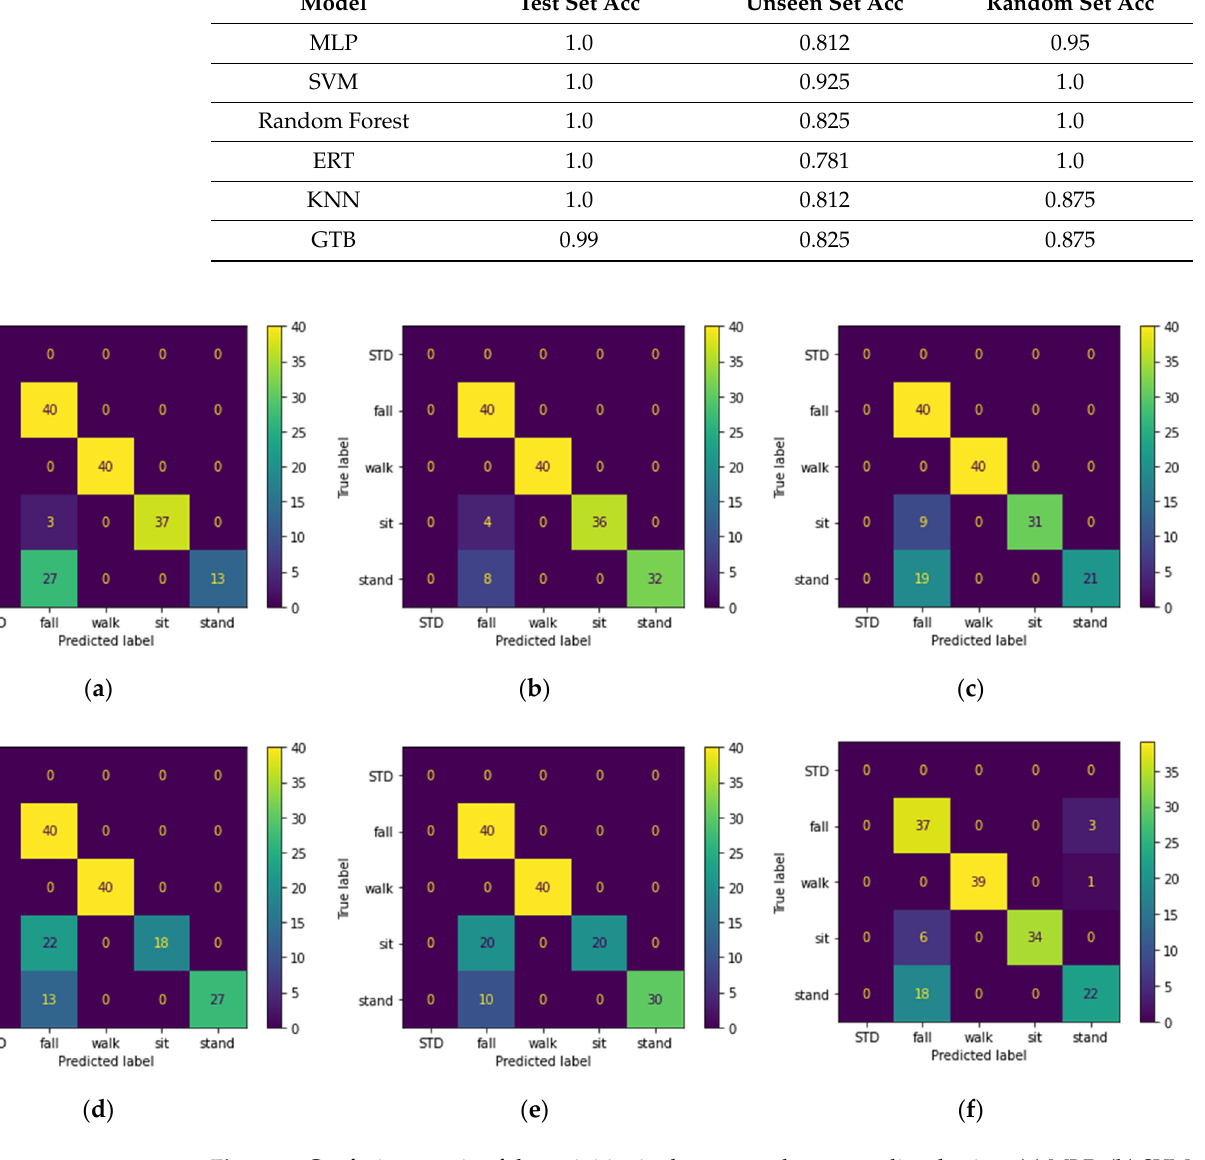
Table 3. Accuracy of classification models for Acoustic features.